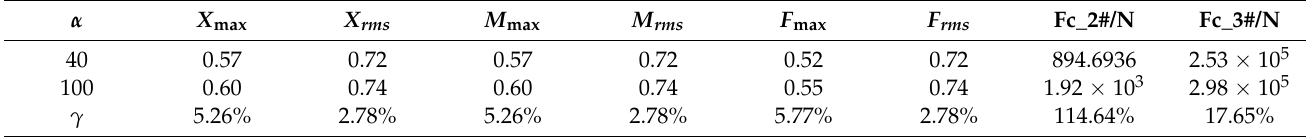
Figure 4. Response of the composite structure with the weight coefficient: ( a ) displacement of main beam; ( b ) bending moment of pier #2; ( c ) shear of pier #2 bottom; ( d ) control effect; ( e ) control force. After determining the coefficient α of the weight matrix, the value of the active optimal control force can also be determined. The peak value changing of the optimal control force is analyzed when the value of α is 40 and 100 in Table 1. In the table, Fc_2# and Fc_3# represent the peak active control force of pier #2 and pier #3, respectively, and γ is the growth rate caused by the change in the weight coefficient α . Table 1. Variation of active optimal control power with weight coefficient.